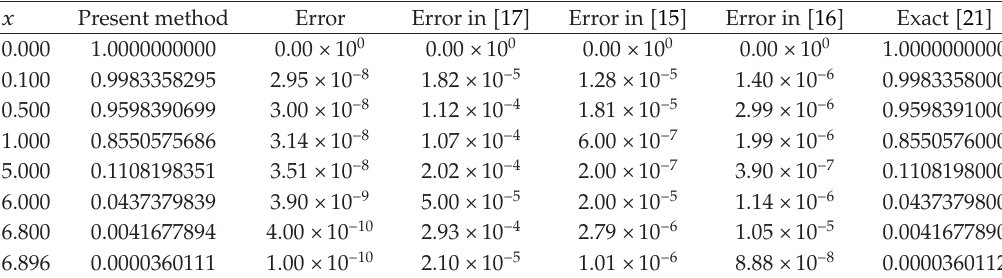
Table 4: Comparison of y (cid:3) x (cid:4) for present method, and other methods in the literature for α (cid:5) 3.